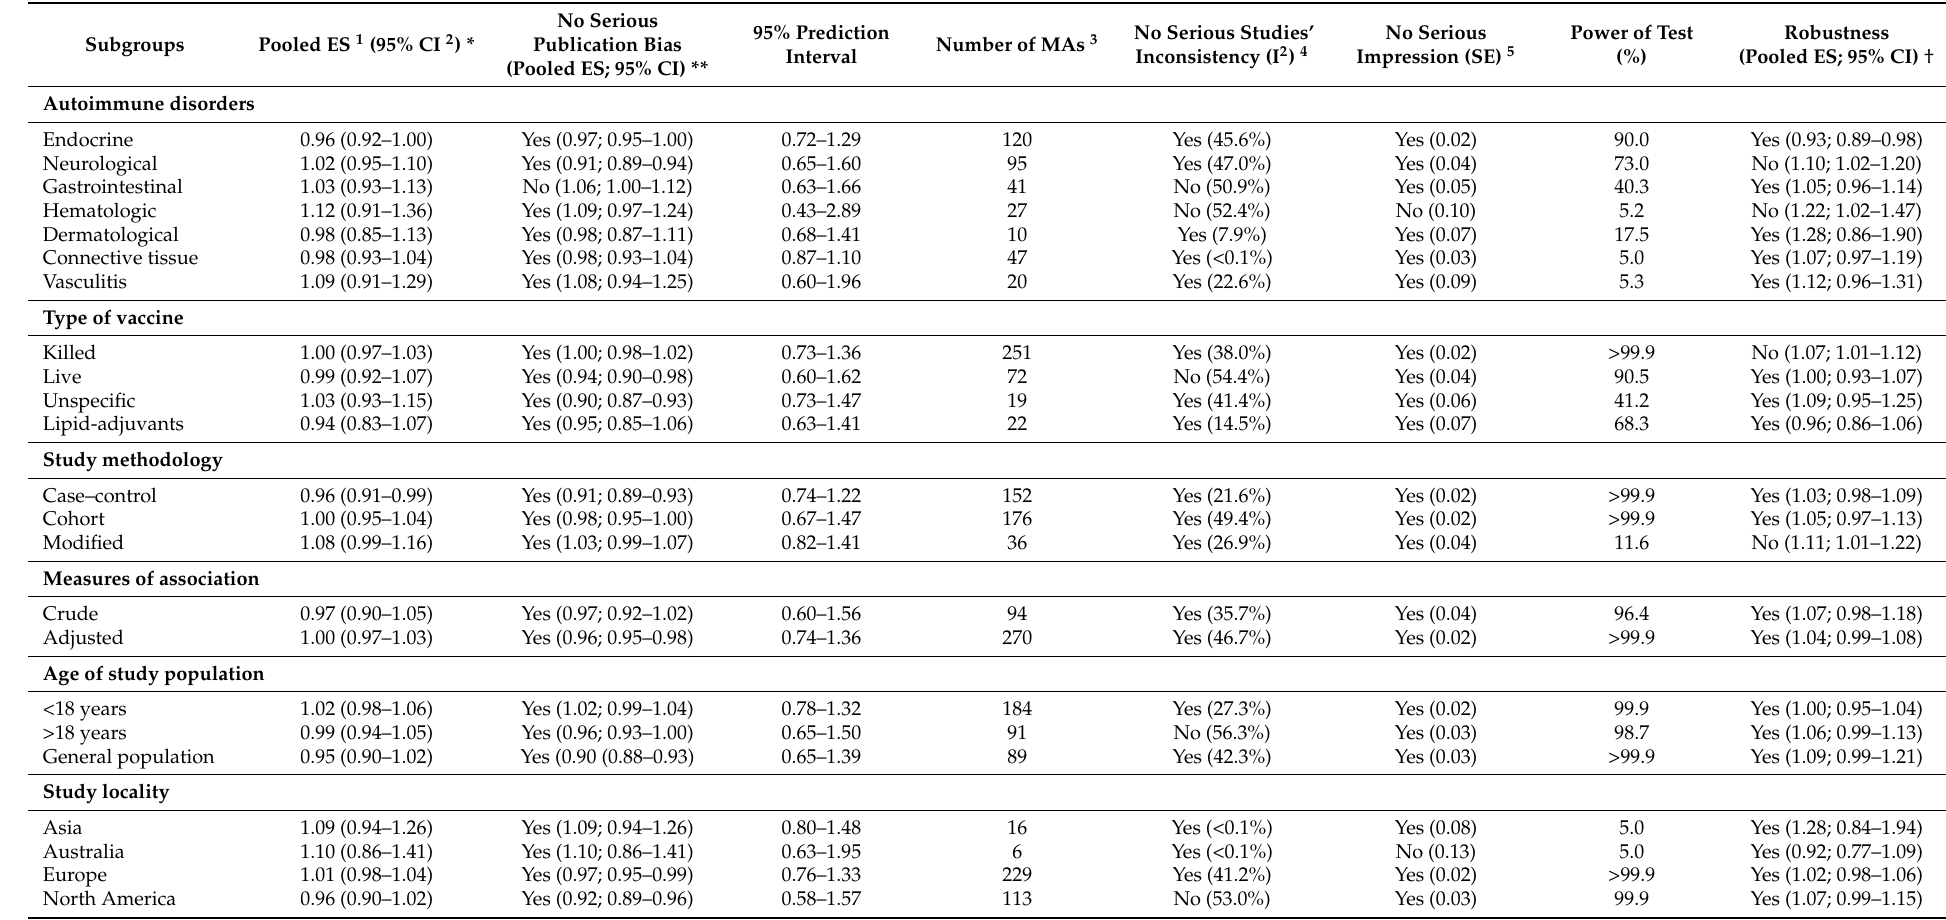
Table 3. Subgroup analysis of effect size, including parameters of strength of evidence, robustness, and prediction